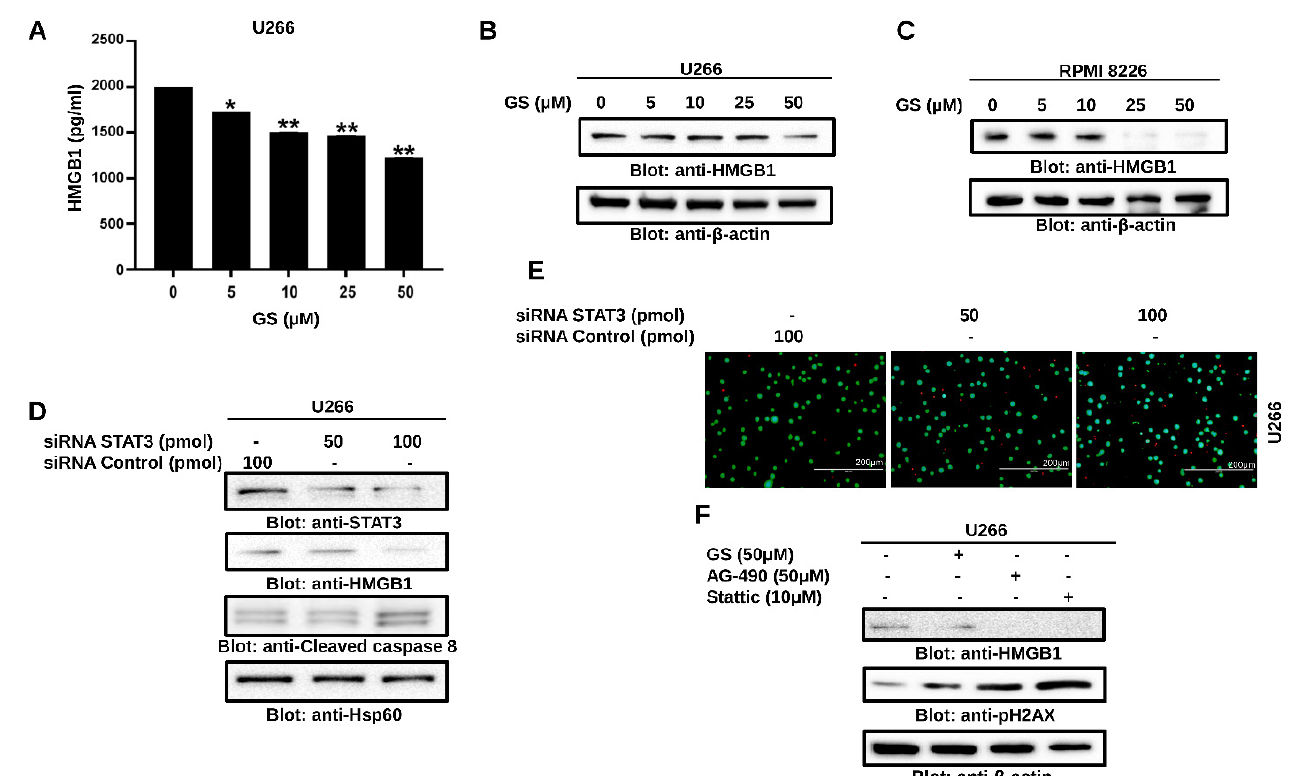
Figure 5. GS downregulates HMGB1 expression via the JAK/STAT signaling pathway. U266 cells were incubated with GS for 48 h and cell supernatant was collected and measured for ( A ) levels of HMGB1 using ELISA. The graph displays the mean ± SD of three independent experiments. * p < 0.05, ** p < 0.001. 50µg of proteins from ( B ) U266 and ( C ) RPMI 8226 cells were resolved on SDS- PAGE, and probed against HMGB1 and ꞵ -actin. ( D ) U266 cells were transfected with either control (100 pM) or STAT3 specific siRNA (50 or 100 pM) and protein expression of STAT3, HMGB1, cleaved-caspase-8 and HSP60 was determined. ( E ) Cell viability was also determined using a live/dead cytotoxicity kit (Scale bar, 200 µm). ( F ) U266 cells were treated with 50 µM GS, 50 µM of AG-490 and 10 µM Stattic for 48 h. A total of 50 µg of proteins were separated on SDS-PAGE and protein expression of HMGB1, p-H2AX and ꞵ -actin were determined. Full Western blot images can be found at Supplementary Materials File S1.